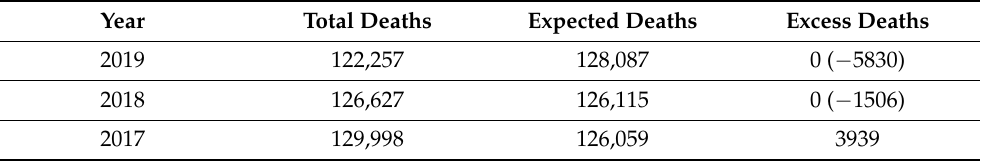
Table 4. Total excess deaths during the summer period (1 June to 15 September) for 2017, 2018 and 2019 based on daily death occurrences. The negative excess death total indicates that the deaths for that year were lower than the average number of deaths for the previous 5-year